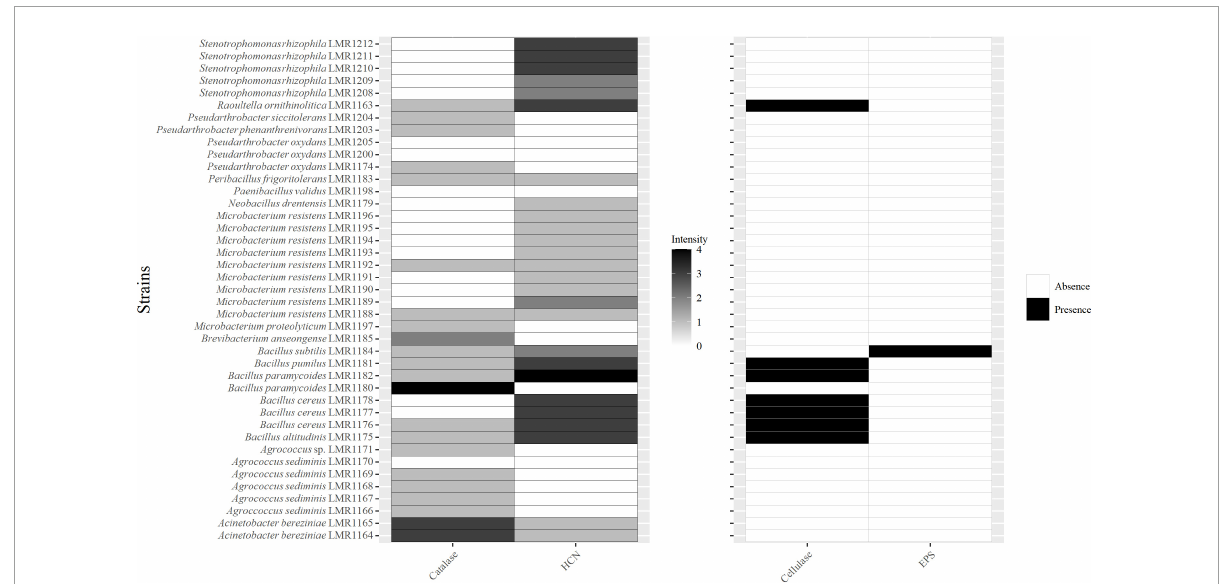
FIGURE3 Heatmap of the capacity of the 41 isolated bacterial strains to produce catalase; hydrogen cyanide (HCN); cellulase and exopolysaccharides. For catalase and HCN; different intensities are presented, 0 for no activity, 1 for low activity, 2 for medium activity, 3 for high activity, and 4 for very high